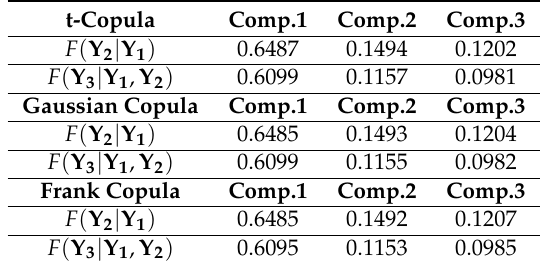
Table 4. PCA variance proportions with simulated multivariate data.